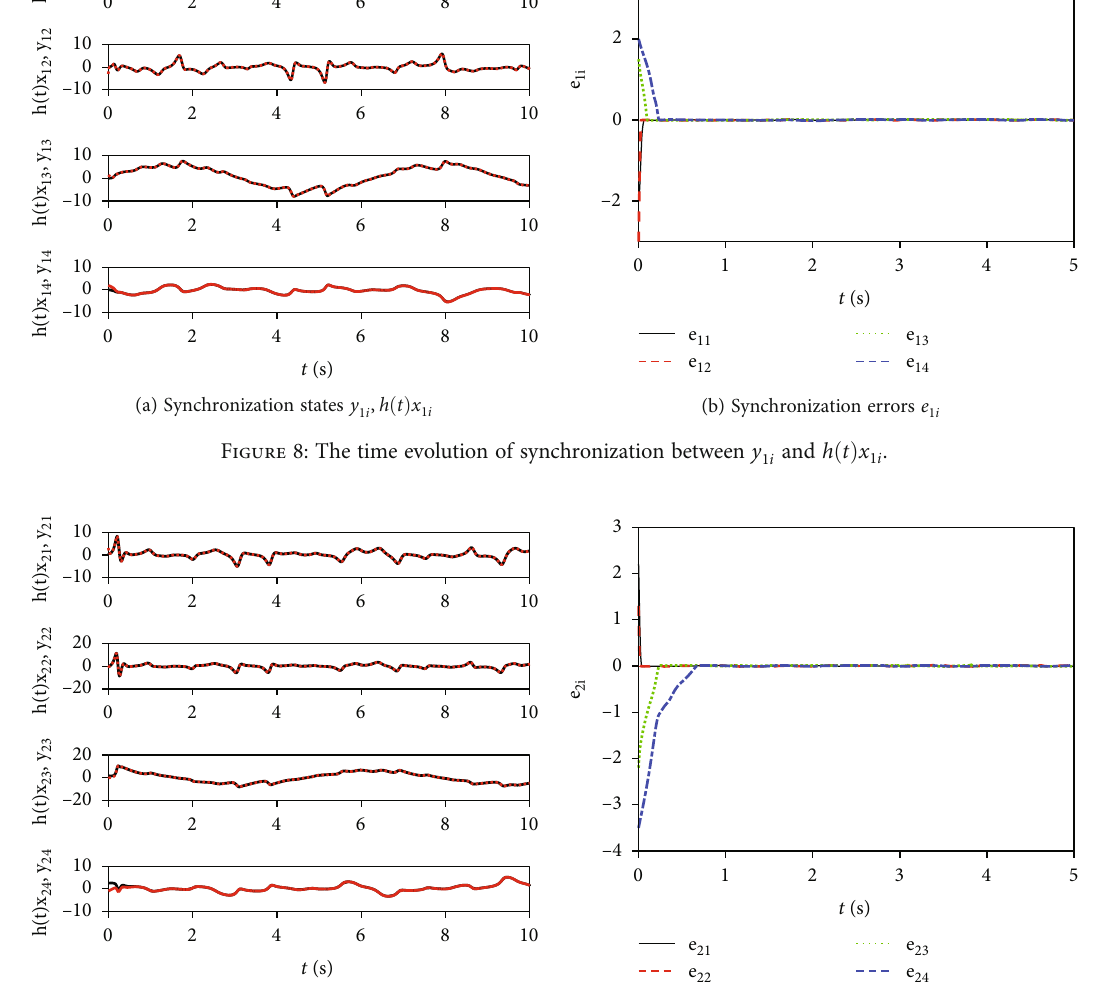
and h ð t Þ x . 2 i 2 i